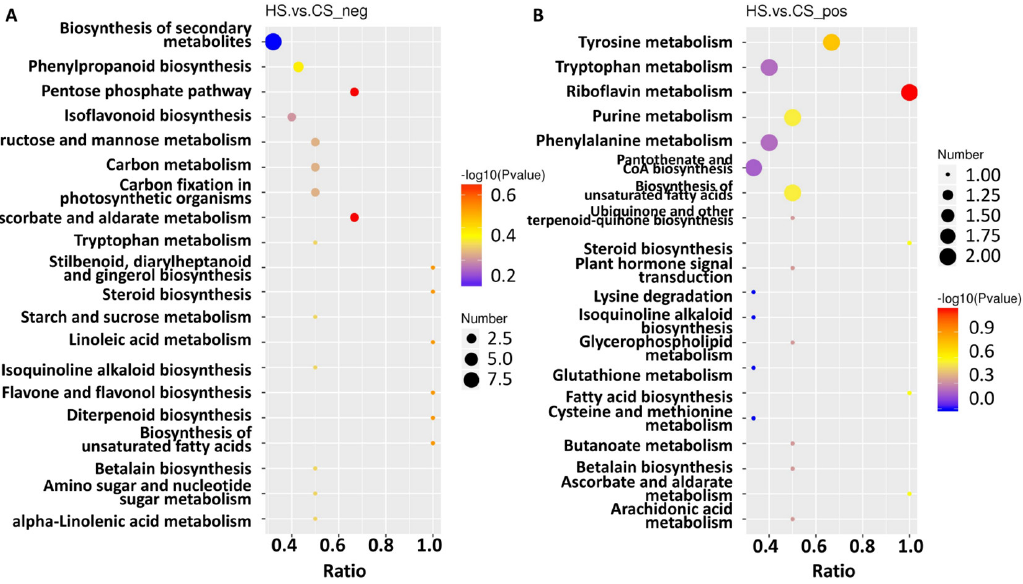
Figure 5. KEGG enrichment of the differential metabolites. ( A ) Metabolites identified in negative mode. ( B ) Metabolites identified in positive mode. The size of the dots corresponds to the number of DEGs in each pathway. The color displays the significance of enrichment. Ratio means the number of metabolites in this pathway with regard to the total enriched metabolite